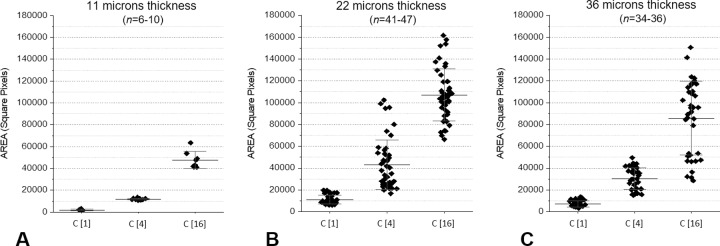
Diffusion of microbes in VSMCs with different thicknesses: (3A) 11μm, (3B) 12μm, (3C) 36μm. Measurement of the areas in three different microbial concentrations (1:4 dilutions). See also the text.